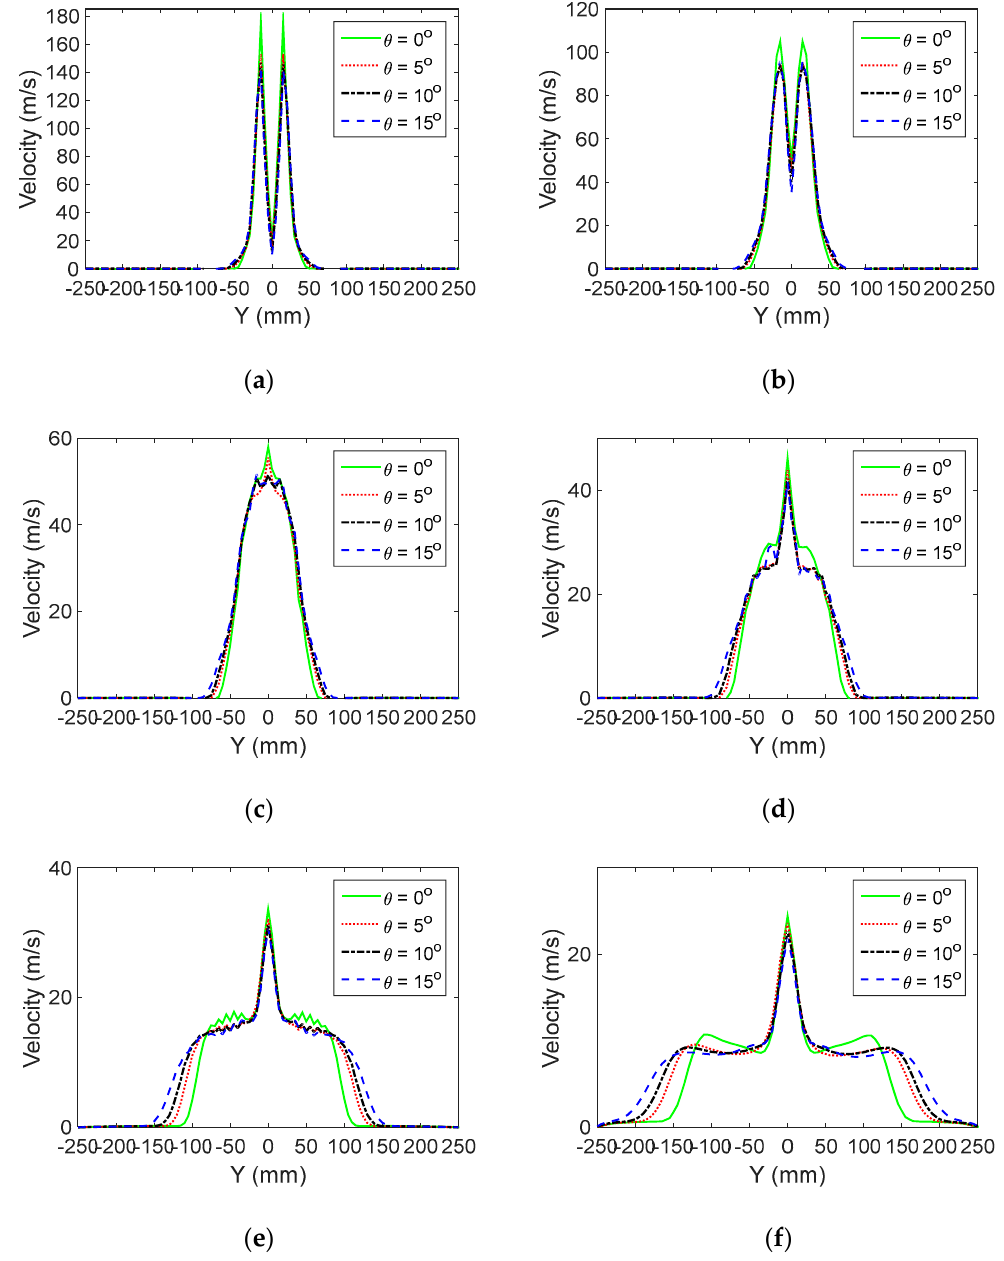
Figure 9. Velocity profiles along the y -axis direction for each cross-section when L = 30 mm: ( a ) y = 15 mm; ( b ) y = 25 mm; ( c ) y = 35 mm; ( d ) y = 50 mm; ( e ) y = 100 mm; ( f ) y = 170 mm.